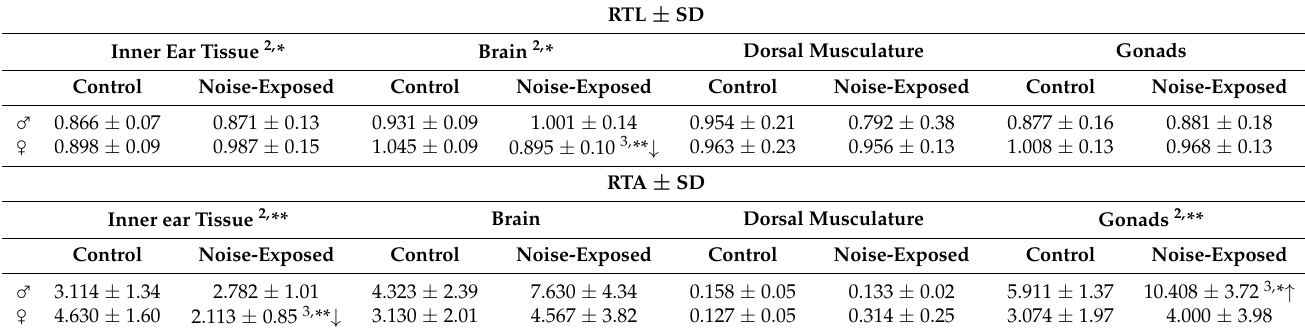
Table 3. Relative telomere length (RTL) and telomerase activity (RTA) in different stone sculpin tissues 1